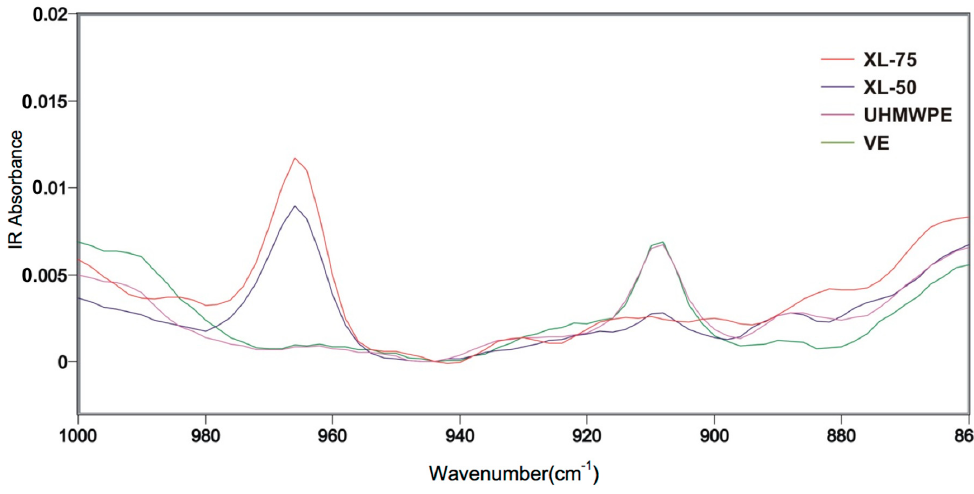
Figure 6. FTIR spectra of the investigated materials.